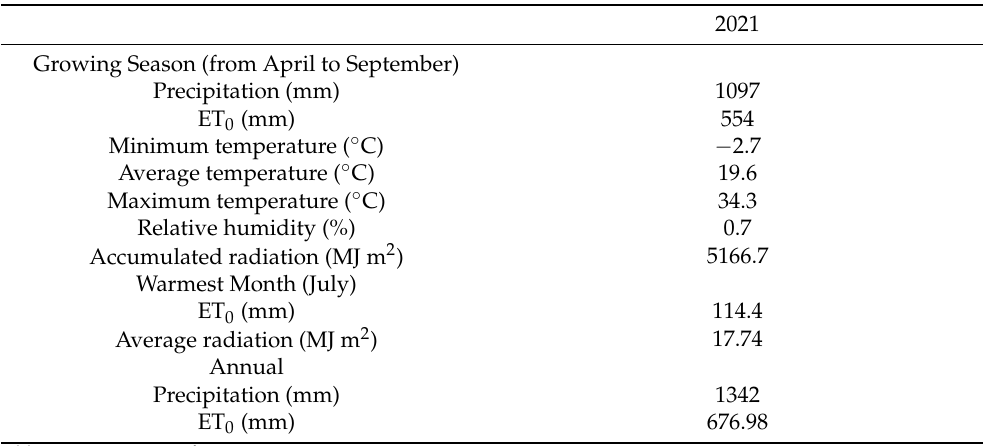
Table 3. Climatic information of the experimental site provided by the Benxi Meteorological Admin- istration during 2021 season.